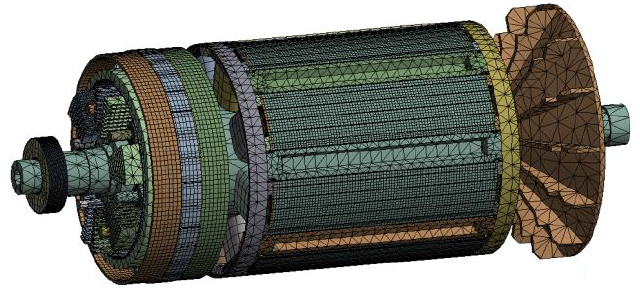
Figure 14. Generator rotor mesh sectioning model.